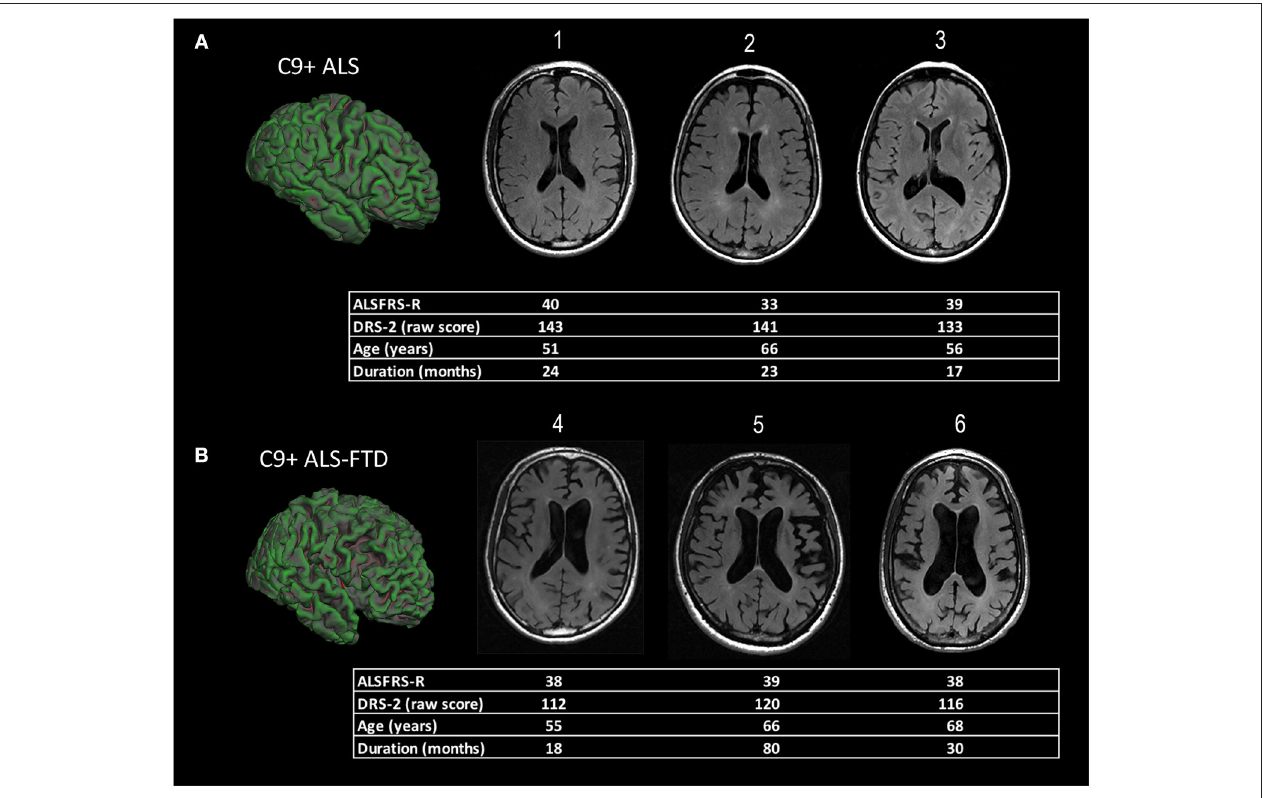
FIGURE 1 | Representative examples of diffuse cortical atrophy in MRI scans of ALS patients with C9orf72 mutations. The demographic information and scores on motor and cognitive scales are listed below each patient’s scan. (A) Compared to age-matched controls, mild ventricular enlargement was seen in C9 + patients 1, 2, and 3 who had ALS, but good cognitive function, as evidenced by their scores on the Mattis Dementia Rating Scale − 2 (DRS-2). The surface rendering of one patient [left side of panel (A) ] shows sulci in frontal lobe sulci are also mildly enlarged compared to the occipital lobe. (B) C9 + patients 4, 5, and 6 had ALS-FTD with a similar degree of motor dysfunction to those in panel (A) , as measured by their ALS functional rating scale revised (ALSFRS-R) scores, but marked cognitive impairment with low DRS-2 scores. There is marked enlargement of ventricles evident in axial slices, as well as enlargement of frontal and temporal sulci in the surface rendering at left of panel (B)